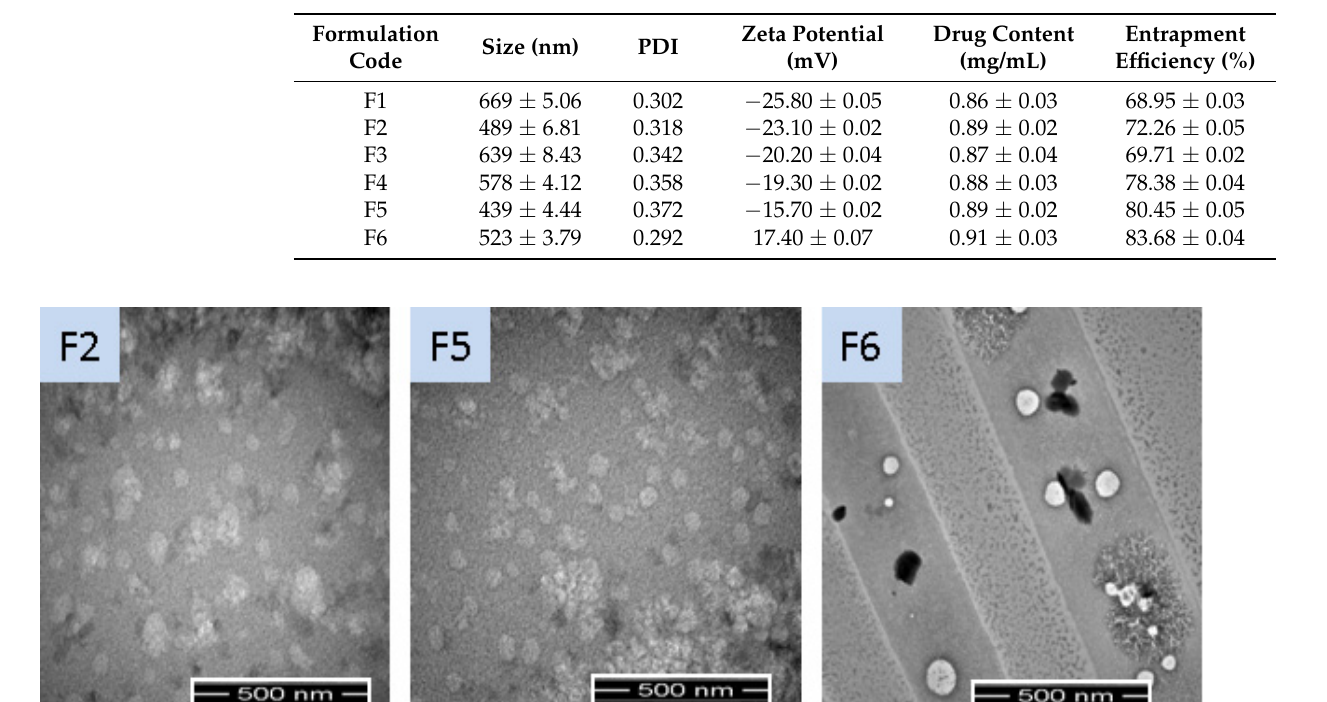
Table 2. Physicochemical characteristics of the SLNs.